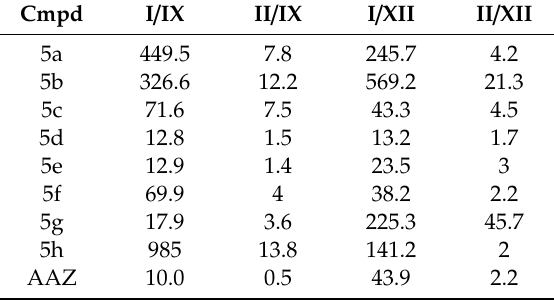
Table 2. Selectivity ratios for the inhibition of hCA IX and XII over hCA I and II for diamide-based benzenesulfonamides 5a–h and